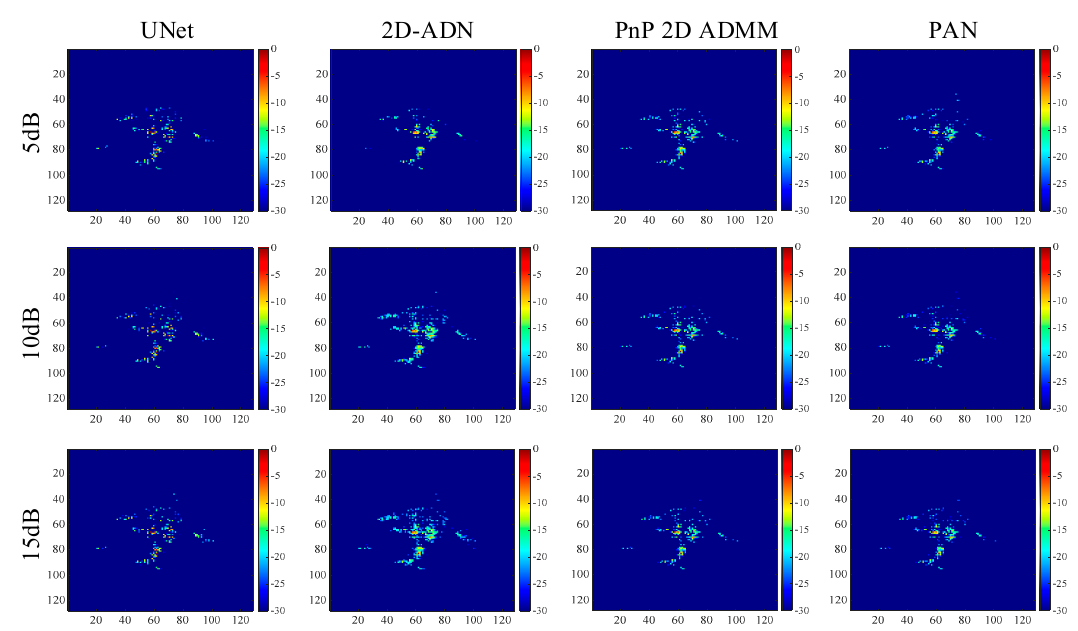
Figure 6. ISAR images of another measured dataset with different SNRs. Table 6. Performance evaluation for another measured 2D incomplete dataset under different SNR conditions.